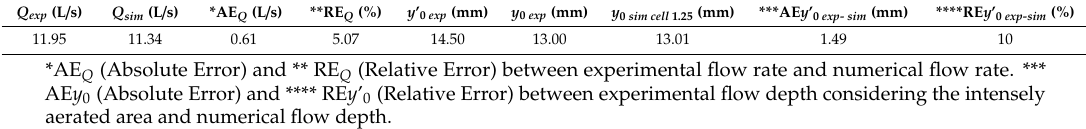
Table 4. Comparison between experimental and numerical flow rate and flow depth for